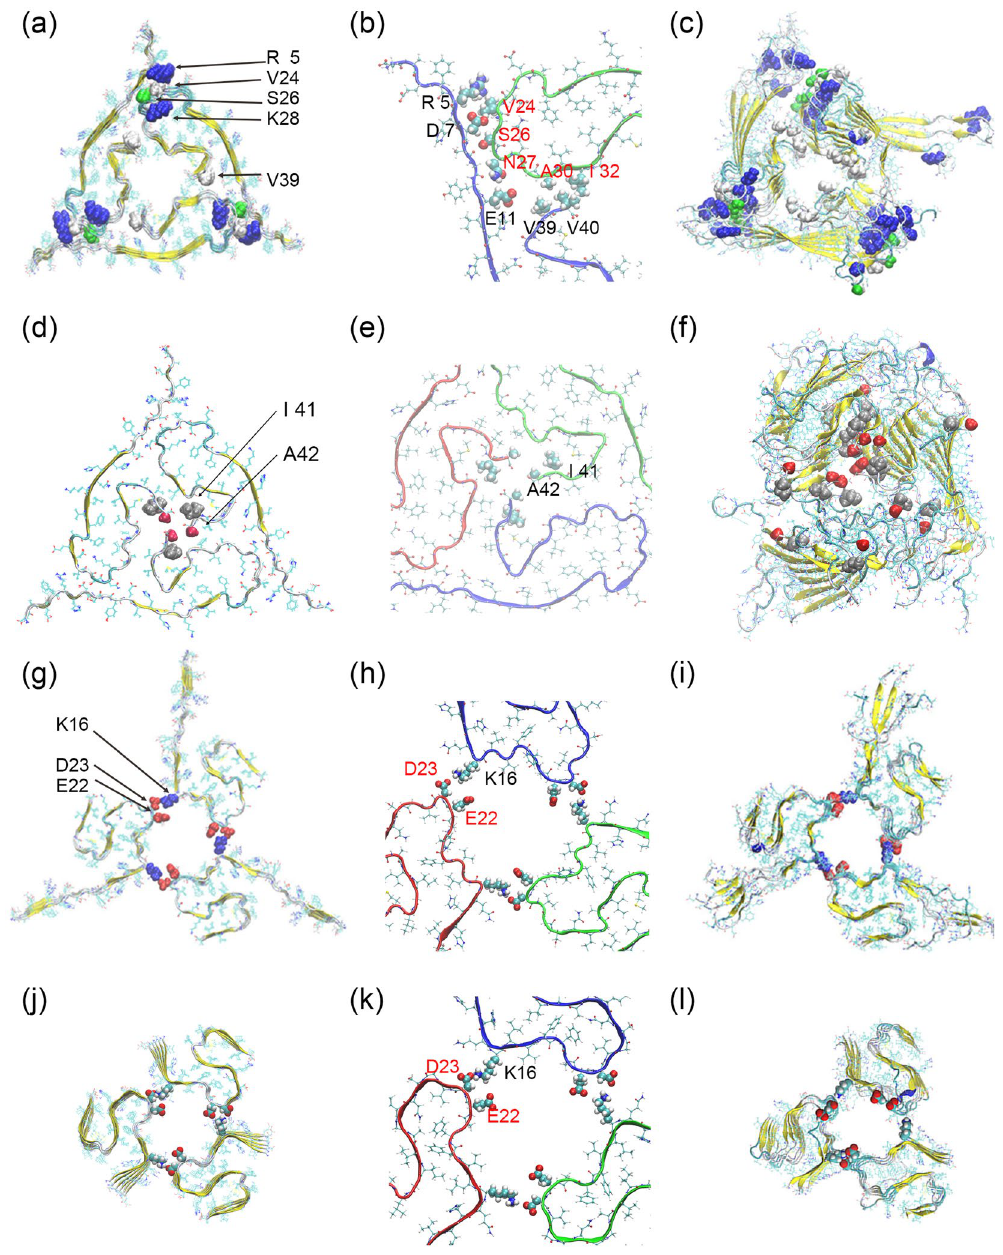
Figure 4. Conformation of three-fold models. A β 1–40 ( a ) initial conformation and ( c ) final conformation after 200 ns of molecular dynamics; the above packing model extended to A β 1–42 , ( d ) initial conformation and ( f ) final conformation after 200 ns of molecular dynamics; A β 1–42 three-fold model with our proposed packing, ( g ) initial conformation and ( i ) last conformation after 200 ns of molecular dynamics; the same three-fold model, but for A β 11–42 , ( j ) initial conformation and ( l ) last conformation after 200 ns of molecular dynamics. The corresponding side chain packing of the initial conformations are also shown in detail in ( b , e , h , k